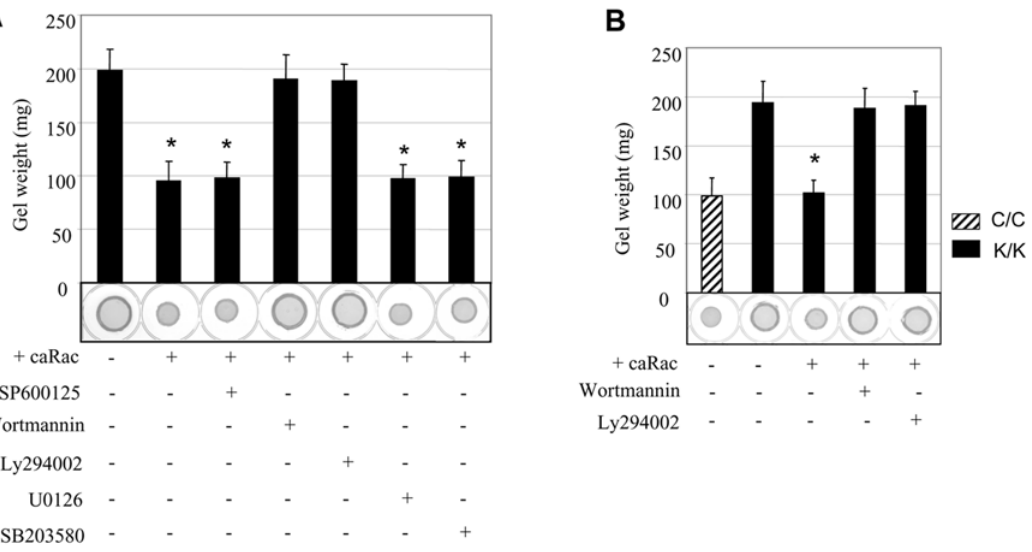
Figure 7. Overexpression of rac in normal fibroblasts results in a profibrotic phenotype phenotype in a PI3kinase/Akt-dependent fashion: collagen gel contraction analysis. (A) Transfection of constitutively active rac (ca rac), compared to empty expression vector (empty), increases ECM contraction by normal fibroblasts. Eighteen hours post-transfection, cells were subjected to the floating collagen gel model of ECM contraction in the presence or absence of 100 nM wortmannin, 10 m M Ly294002, 10 m M U0126 or 10 m M SP600125. Average + / 2 standard deviation is shown (N=3, *=p , 0.05). (B) Rac overexpression rescues the reduced ECM contraction in rac knockout fibroblasts (K/K) versus control fibroblasts (C/C). Cells were transfected with empty expression vector or constitutively active rac (ca rac) in the presence or absence of wortmannin or Ly294002. (*, p , 0.05, Student’s t test).